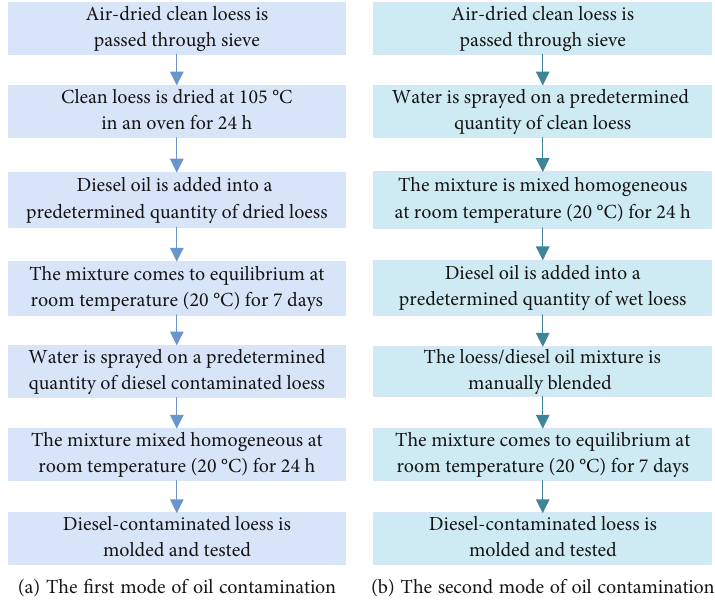
Figure 3: Specimen preparation methods of loess under two di ff erent modes of oil contamination. Table 3: Results of compression tests under the two di ff erent modes of oil